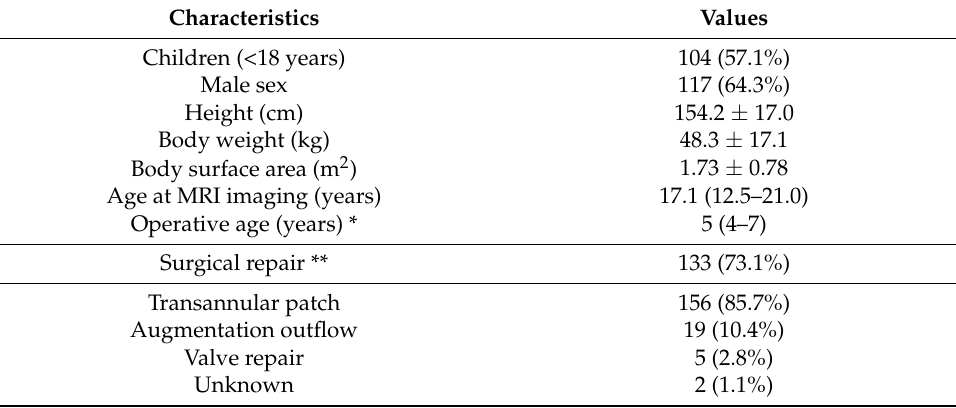
Table 1. Patient clinical characteristics (n = 182).